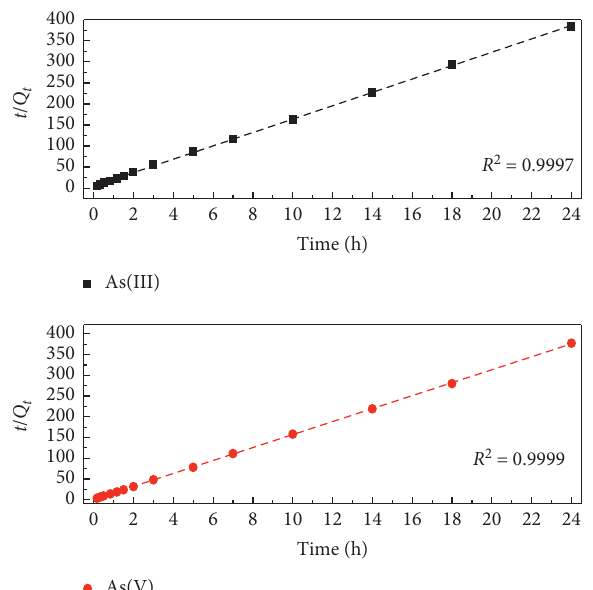
Figure 9: The pseudo-second-order kinetic plots for removal of As(III) and As(V) at pH � 8, adsorbent dosage 0.5 g, and initial arsenic concentration 1.3